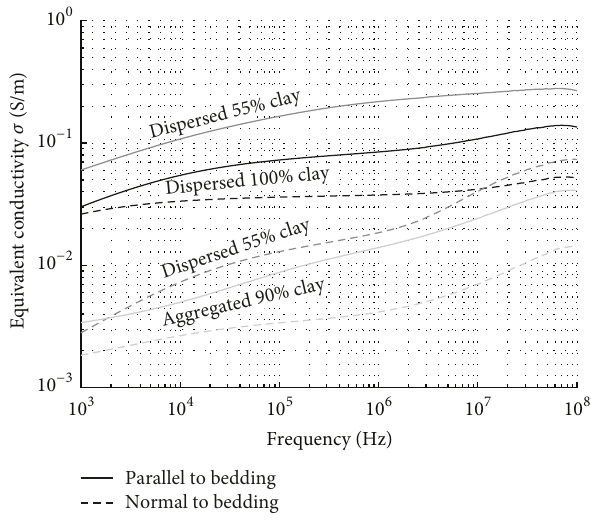
Figure 10: Effect of microstructure on conductivity of artificial shales measured parallel and normal to the bedding plane.